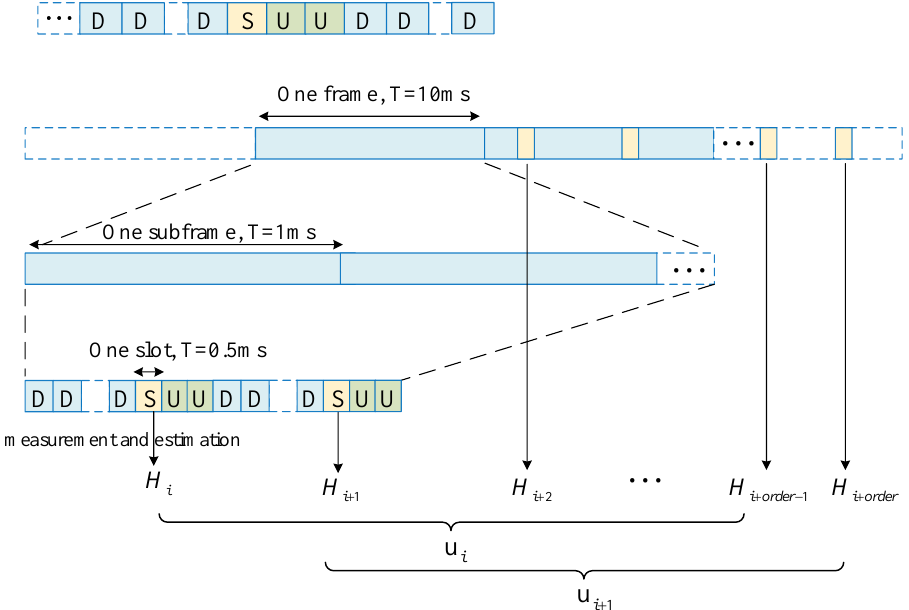
Figure 3. An illustration of the input and output pairs in a channel prediction